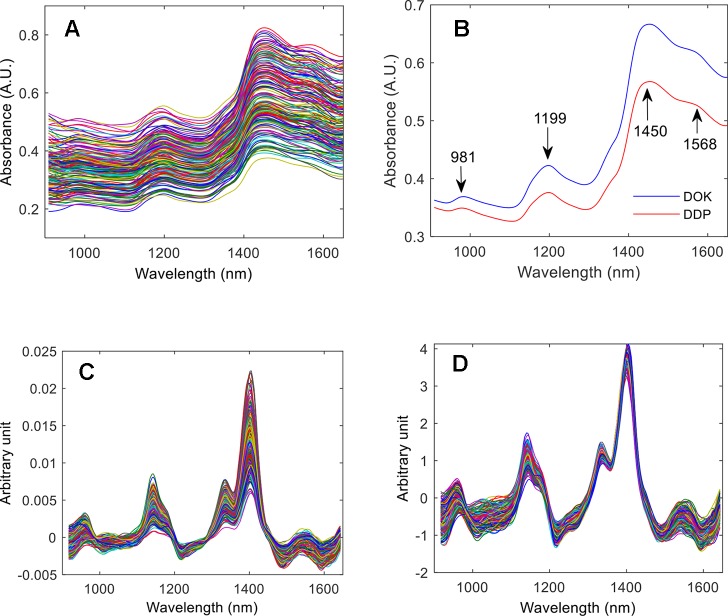
The raw NIR spectra of the fengdou calibration set (A), the mean spectra of the DOK and DDP calibration samples (B), the NIR spectra after pretreatment by the 1st derivative (C), and the NIR spectra pretreated by the 1st derivative and subsequent SNV (D).